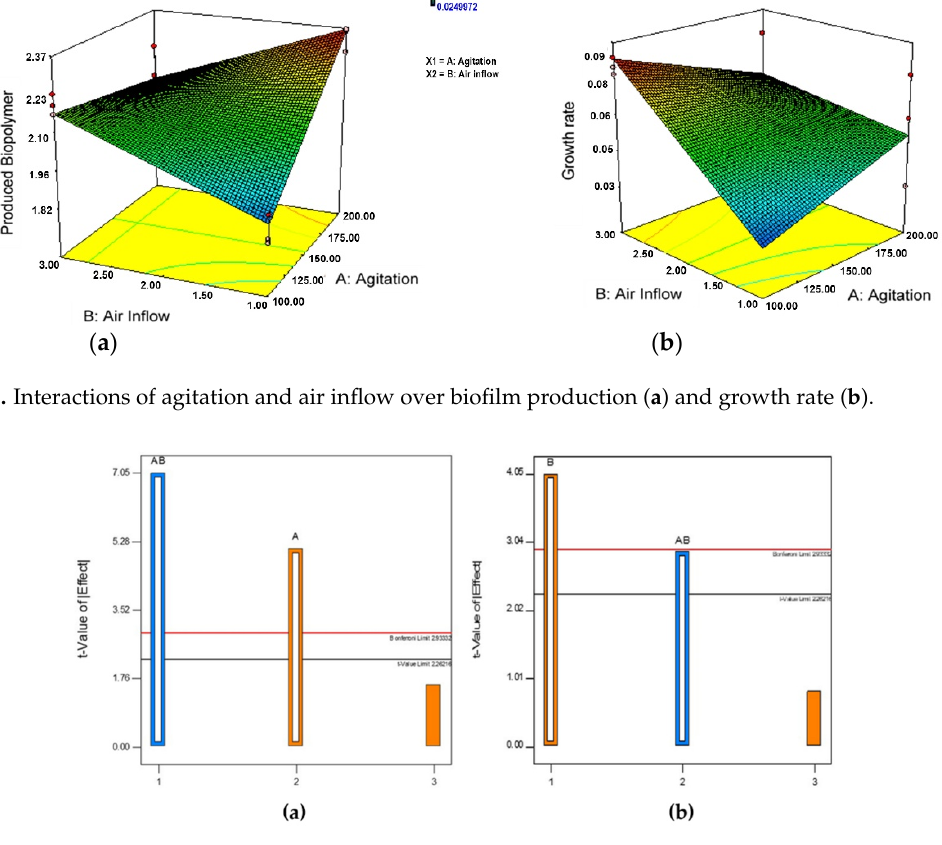
Figure 4. Pareto charts of standardized effects for biofilm production ( a ) and growth rate ( b ); A is agitation and B is